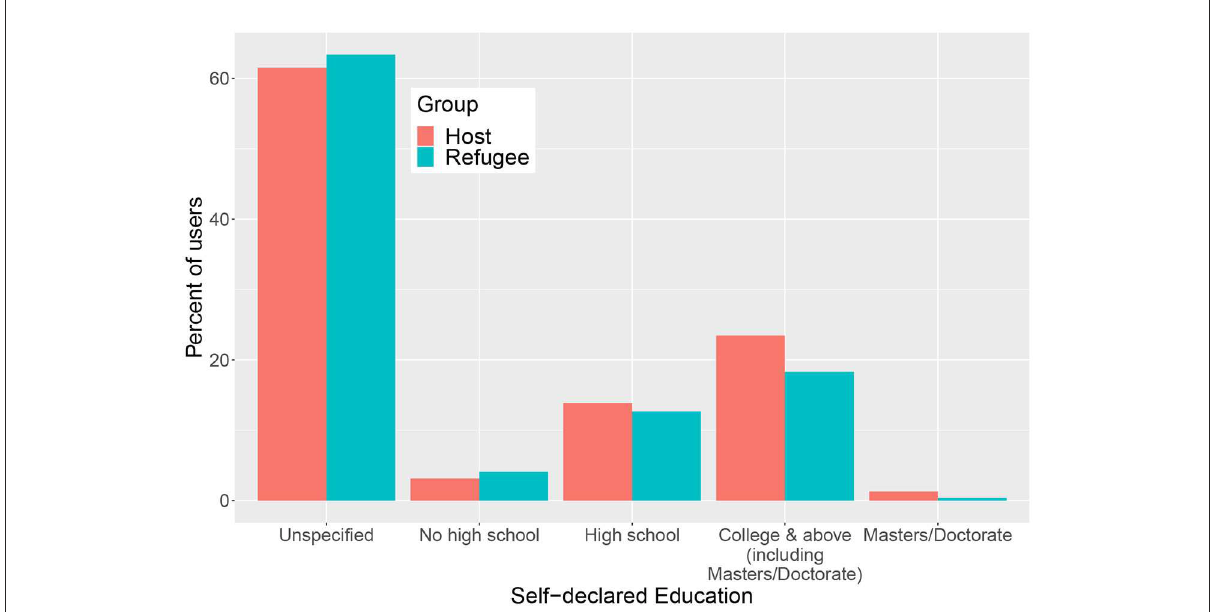
FIGURE7 Percentage of users in Lebanon aged 13+ with various self-declared education levels for the host and refugee